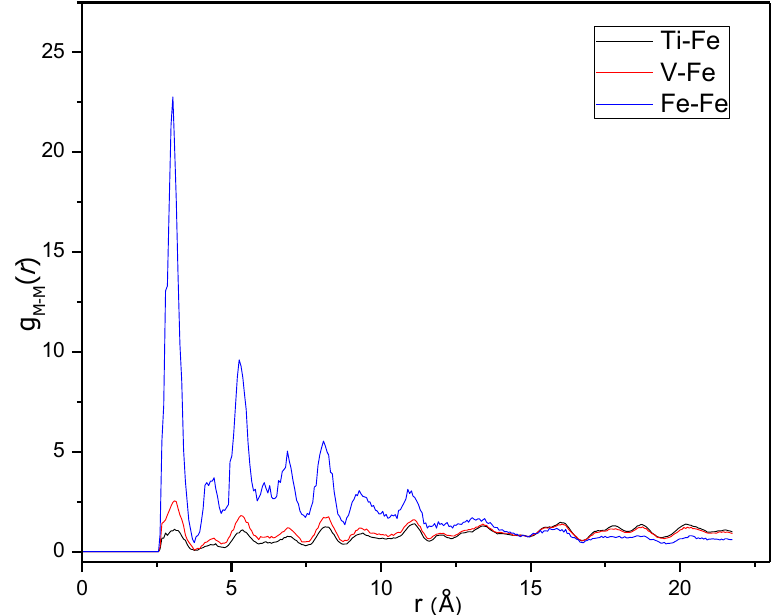
Figure 7. M-Fe partial pair distribution functions g Ti-Fe ( r ), g V-Fe ( r ) and g Fe-Fe ( r ) from the RMC model of Ti 0.63 V 0.27 Fe 0.10 D 1.73.